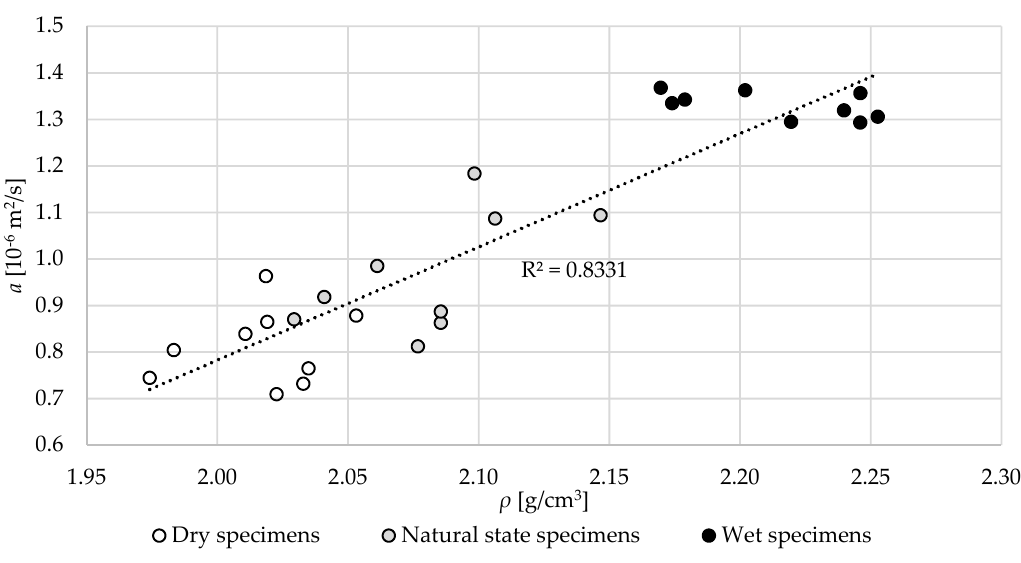
Figure 18. The relation between the volume density, ρ , in different specimen states and thermal diffusivity, a .